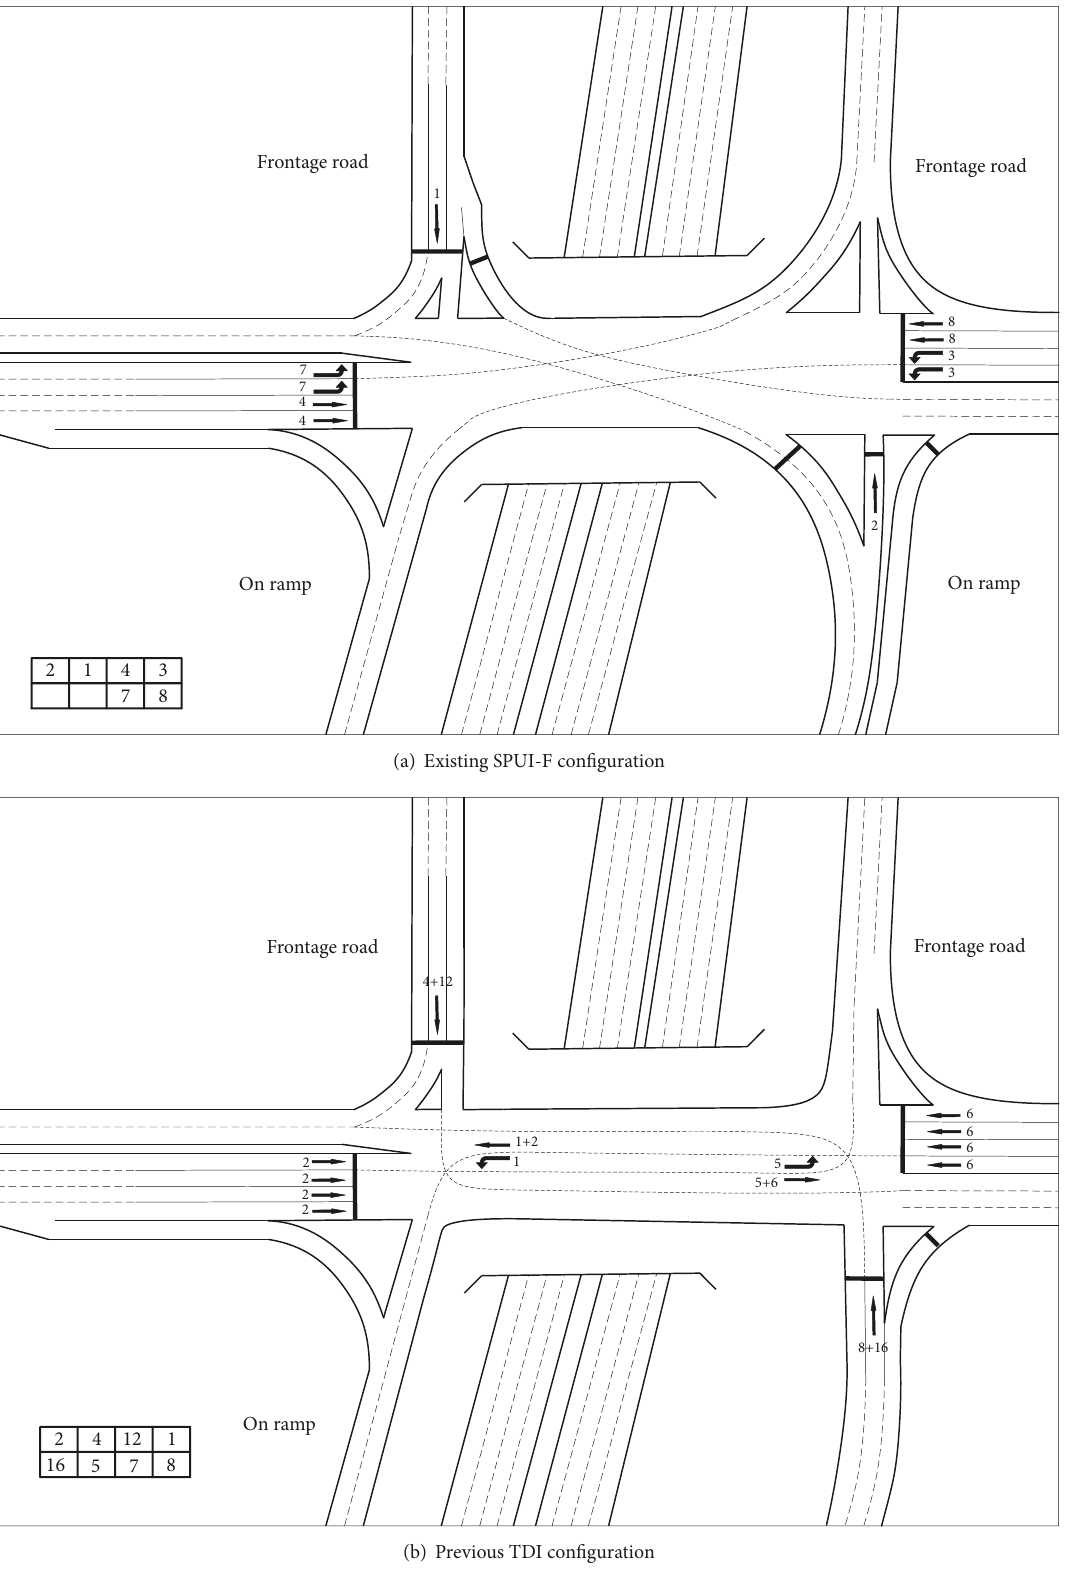
Figure 1: Geometric configuration of I-580/Plumb Ln